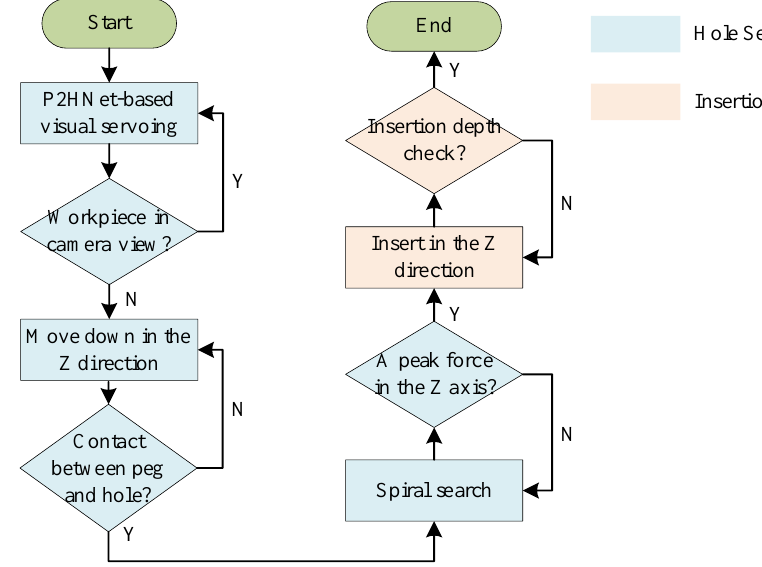
Figure 11. Multi-modal peg-in-hole strategy.